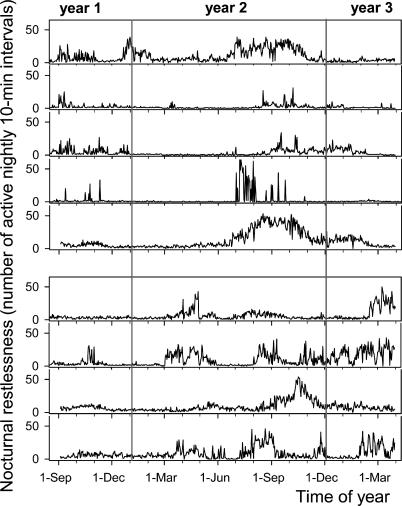
Nocturnal Activity under Constant Photoperiod (Light/Dark 12.25:11.75 h)Activity of five African stonechat males (upper panel) and four females (lower panel) recorded continuously in individual registration cages recorded for 1.5 years. Curves show nocturnal activity (Zugunruhe) as the number of 10-min intervals during which the birds were active at night. Since the birds received no temporal cues, the repeated, spontaneous outburst of nocturnal activity indicates an underlying endogenous component. Vertical gray bars indicate years.